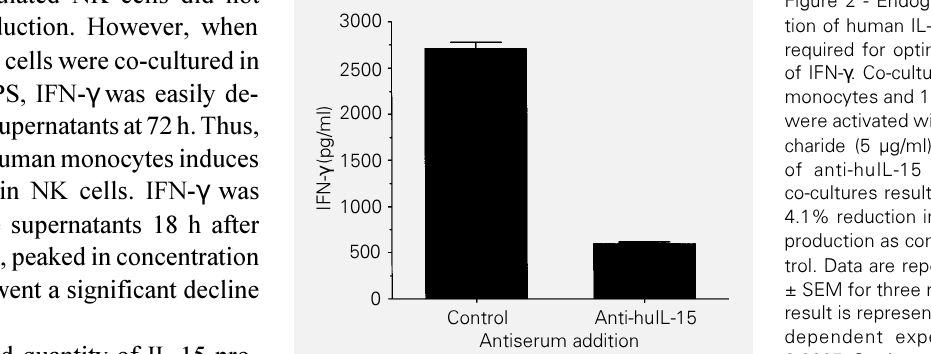
Figure 2 - Endogenous produc- tion of human IL-15 (huIL-15) is required for optimal production of IFN- g . Co-cultures of 1 x 10 5 monocytes and 1 x 10 5 NK cells were activated with lipopolysac- charide (5 (cid:181)g/ml). The addition of anti-huIL-15 antiserum to co-cultures resulted in a 77.2 – 4.1% reduction in NK cell IFN- g production as compared to con- trol. Data are reported as mean – SEM for three replicates. This result is representative of 12 in- dependent experiments (P< 0.0005; Student t